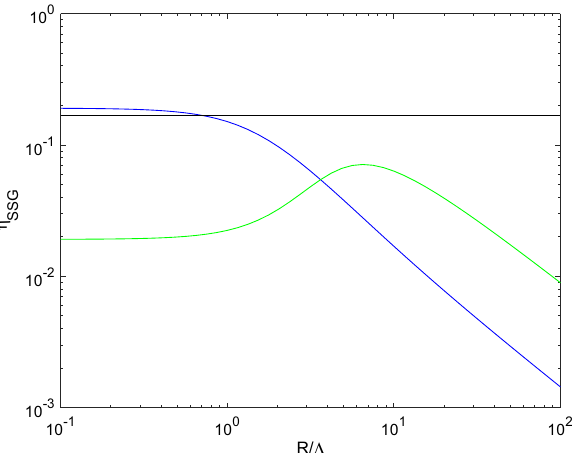
Figure 5. Apparent energy conversion η SSG ( R ) as a function of R /� for the blue and green materials. Comparison with an optimal membrane-based approach (black